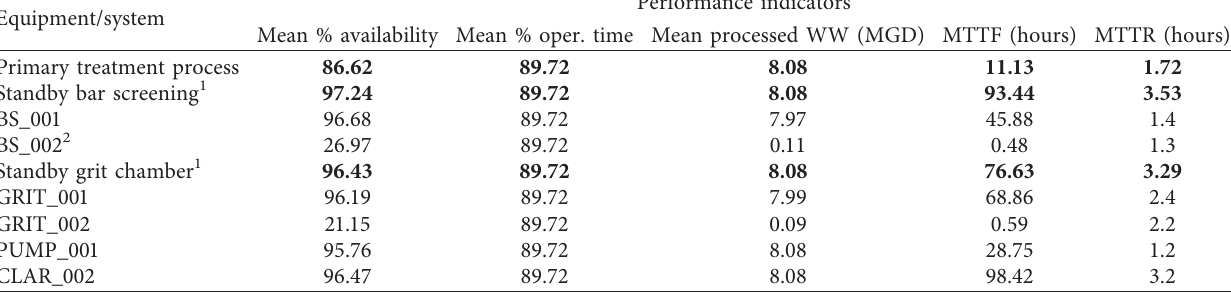
Equipment/system